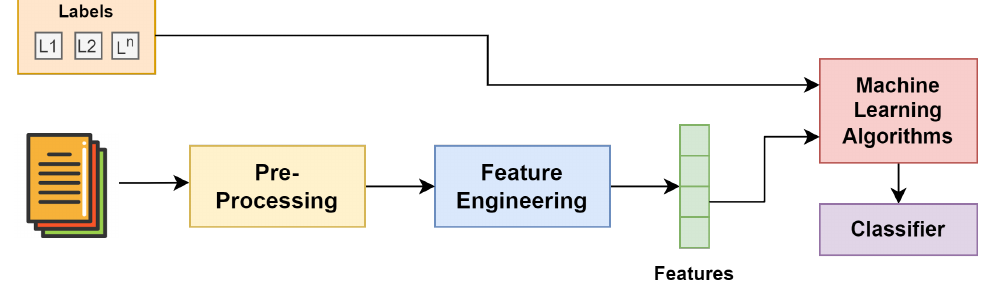
Figure 2. Training pipeline of text classification